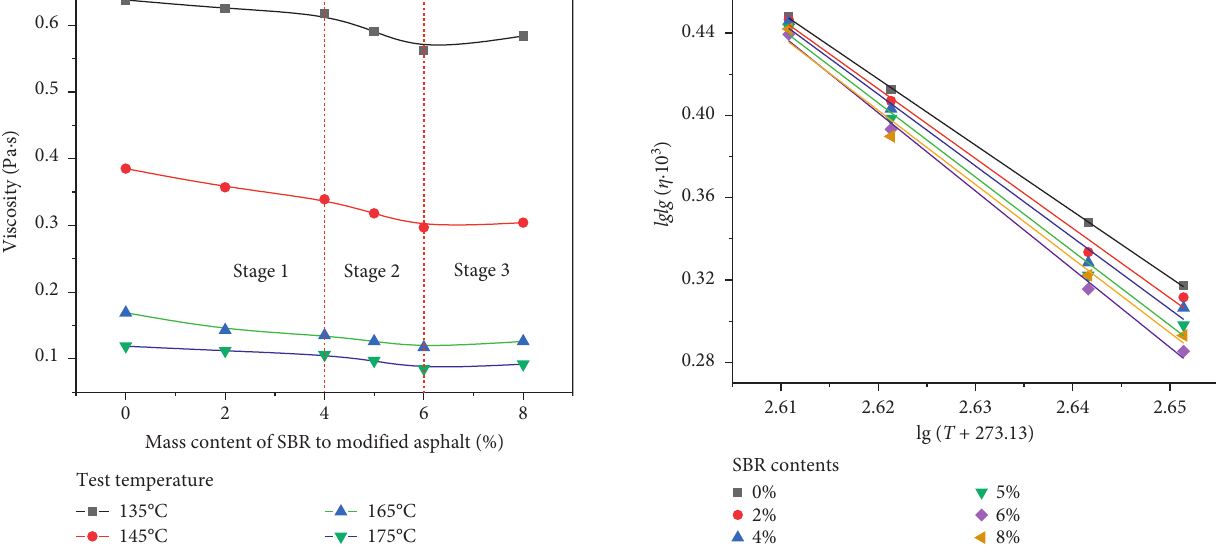
Figure 5: Viscosity-temperature curves of BRA-SBR modified asphalt with different SBR contents.